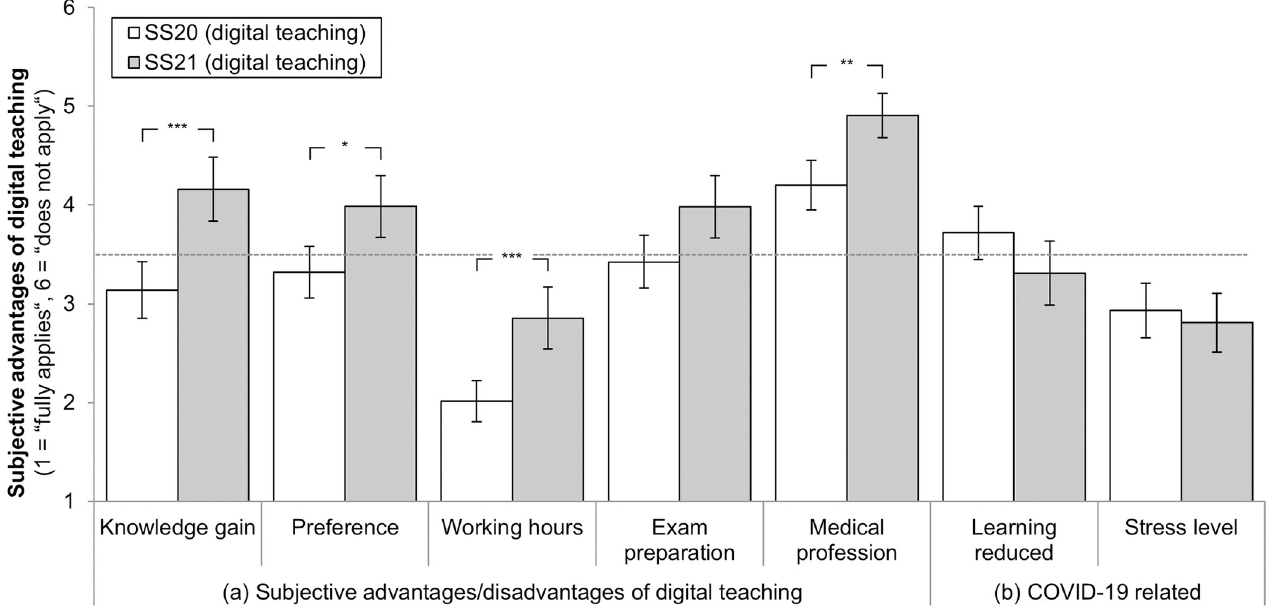
Fig 3. Subjective advantages of digital teaching as rated by students in SS20 ( n = 175) and SS21 ( n = 136). � p < 0.05, �� p < 0.01, ��� p < 0.001. Mean values with 95%-CIs and Bonferroni corrected pairwise comparisons. Students rated statements on a 6-stage scale (1 = “fully applies”, 6 = “does not apply”), e.g., “My knowledge gain in the subject of psychiatry is greater with digital teaching than in classroom teaching” (please see S1 Table for all item formulations): (1) better knowledge gain, (2) preference for digital teaching, (3) more working hours (oder workload), (4) better preparation for the written state exam, (5) better preparation for a medical profession in the future, (6) related to the COVID-19 pandemic: reduction of learning success, (7) related to the COVID-19 pandemic: higher stress level. N =